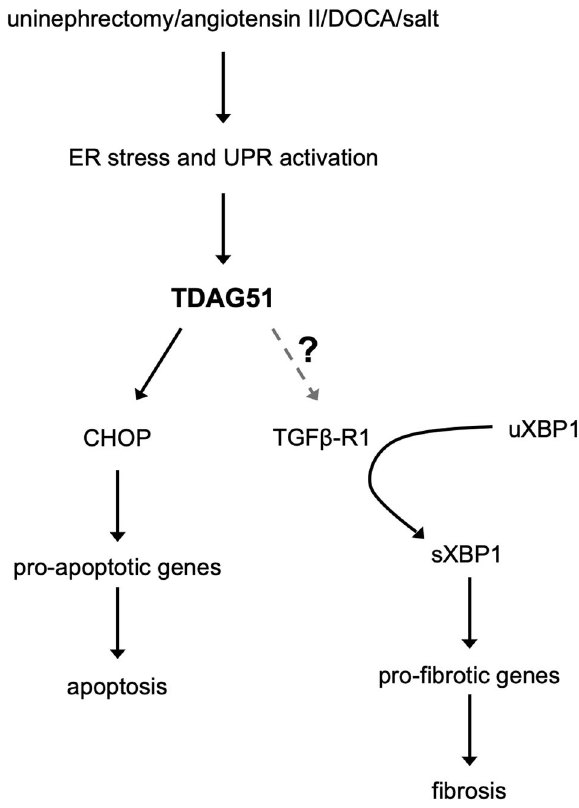
Fig. 7 Model for TDAG51 mediated apoptosis (CHOP pathway) and fi brosis (TGF- β receptor 1 and sXBP1 pathway). The